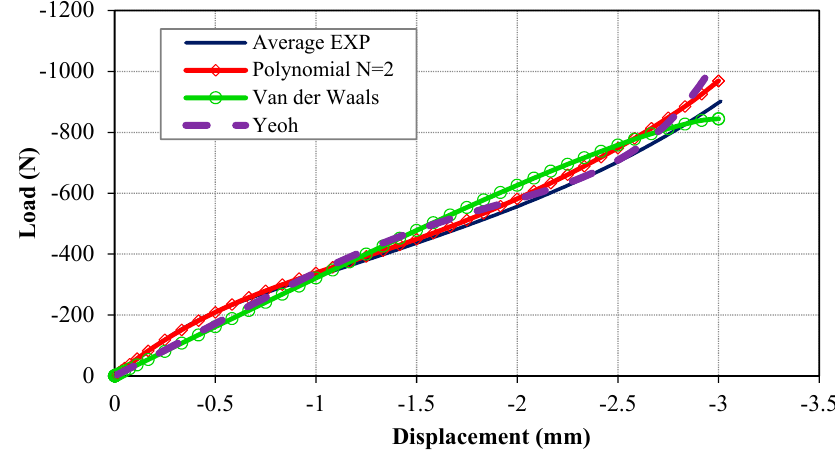
Figure 7. The predicted load-displacement curves and stress–strain responses of the system in comparison with the experimental